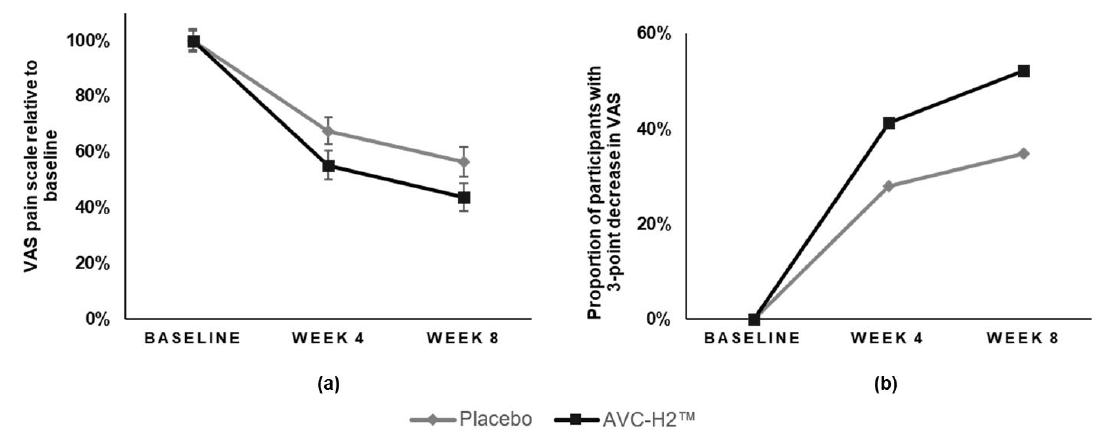
Figure 2. Relative changes in the VAS pain assessment scale and the proportion of participants with a 3-point pain reduction, by intervention group. ( a ) relative change in VAS from the baseline to the follow-up weeks. Baseline VAS was standardized as 100%; ( b ) the proportion of participants who had ≥ 3 points decrease in the VAS pain scale from the baseline to the follow-up weeks. Error bars represent the standard error (SE) for each group at different time points in VAS. Abbreviation: AVC-H2, Avicenna’s Hydrolyzed Chicken Collagen Type II; VAS, Visual Analog Scale.